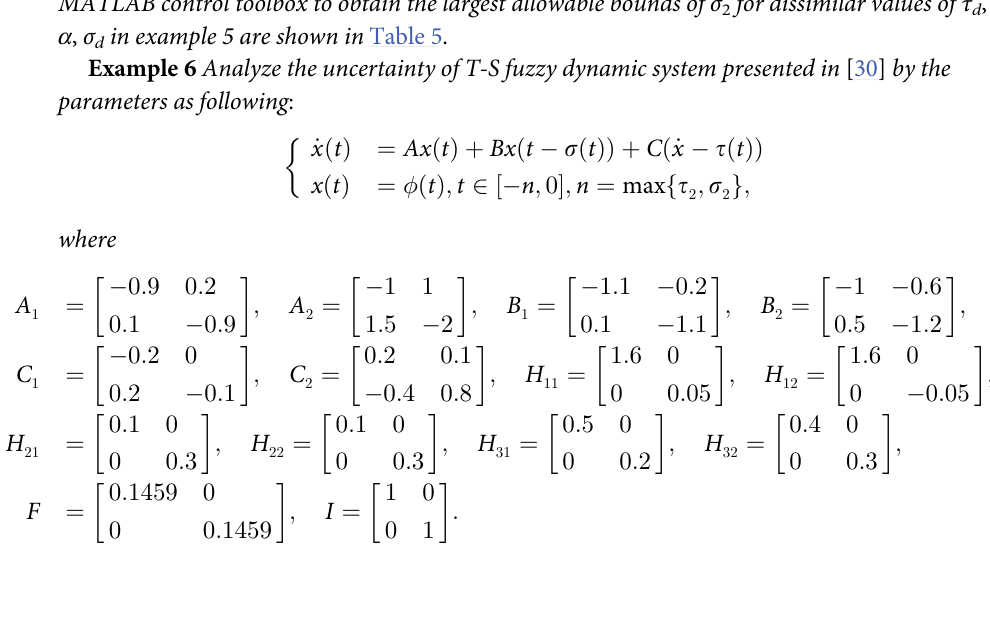
Table 5. The maximum allowable bounds of σ 2 for τ τ d = σ d α = 0.5 α = 0.4 α = 0.3 α = 0.2 α = 0.1 α = 0